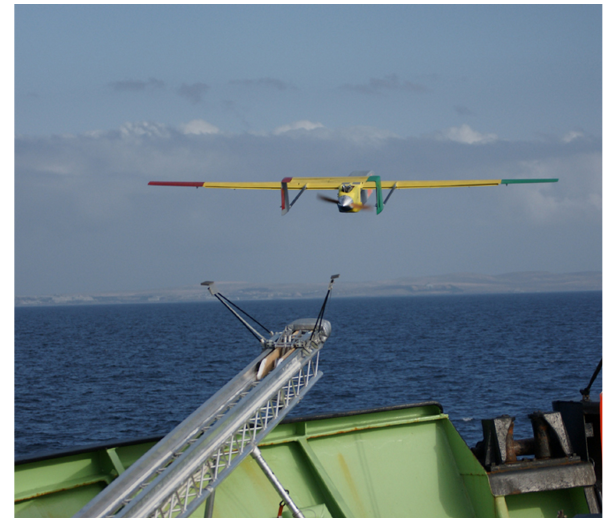
Fig. 2. The NOCS UAV launching from the RRS Discovery, Octo- ber 2008.